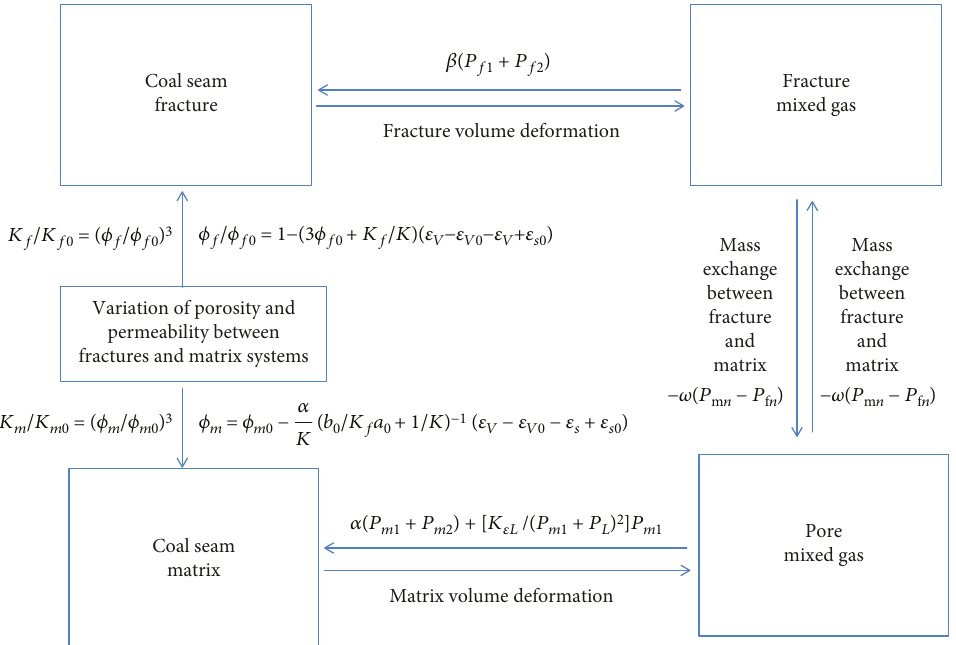
Figure 3: Coupling relationship between coal deformation and methane migration.